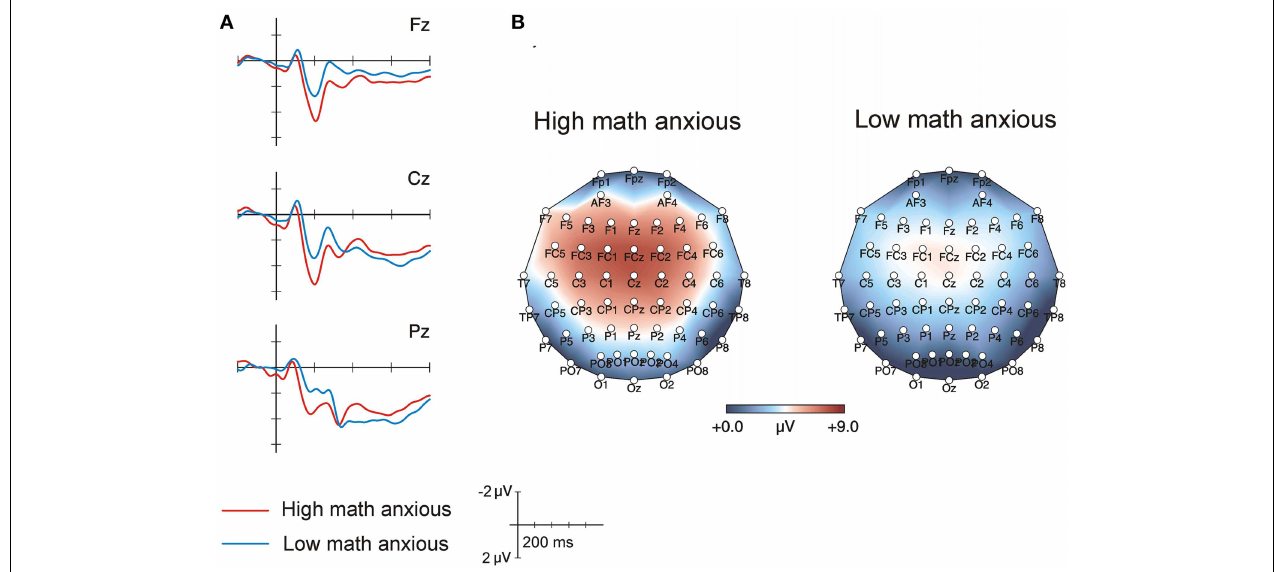
FIGURE 1 | (A) Raw averaged waveforms for HMA ( n = 17 ) and LMA ( n = 17 ) individuals during the calculation phase. (B) Topographic maps waveforms for HMA and LMA individuals in the 175–225ms window of the calculation phase.